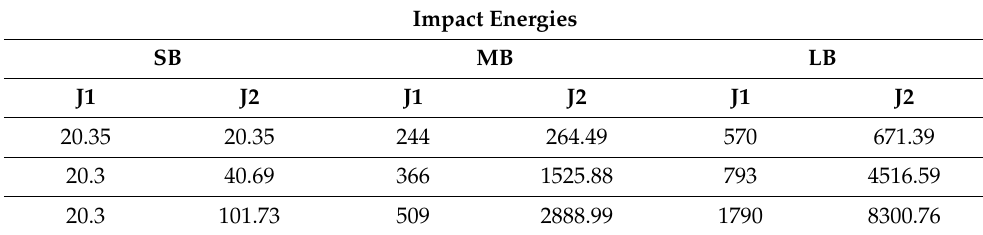
Table 3. Calculated impact energies of the tested